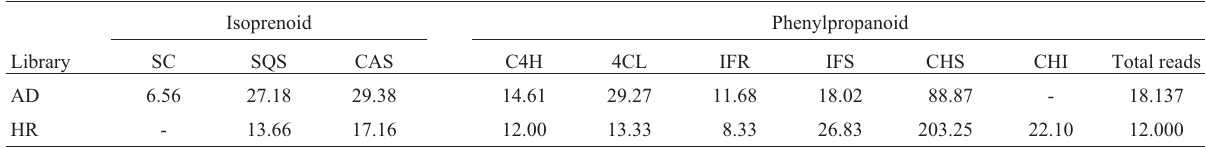
Figure 1 - Cladogram of sugarcane cDNAs coding for putative cycloar- tenol synthase (CAS) and CAS genes from other monocotyledonous and dicotyledonous species. gi:3688598 Panax ginseng ; gi:6045133 Orysa sativa ; gi:6090879 Orysa sativa ; gi:4589852 Glycyrrhiza glabra ; gi:7447118 Garden pea . * Multiple alignment analysis was performed with Clustal X program (www.igbmc.u-strasbg.fr). The length of the horizontal lines indicates an inverse degree of relatedness. Table III - Gene expression pattern of tissues from sugarcane variety SP 70 – 1143. Values represent the ratio of enzyme related transcript abundance (x 10 5 ) multiplied by the total reads of the library in the SUCEST